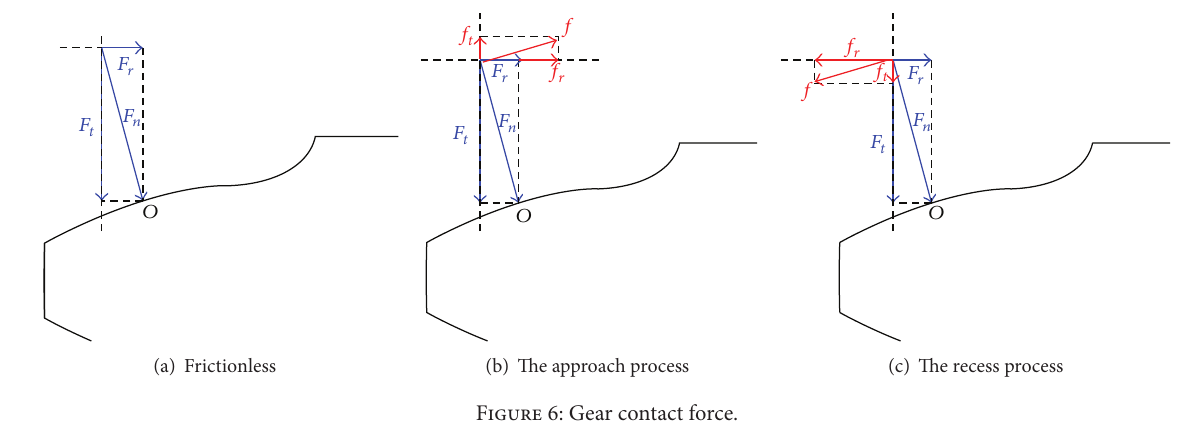
Figure 6: Gear contact force.